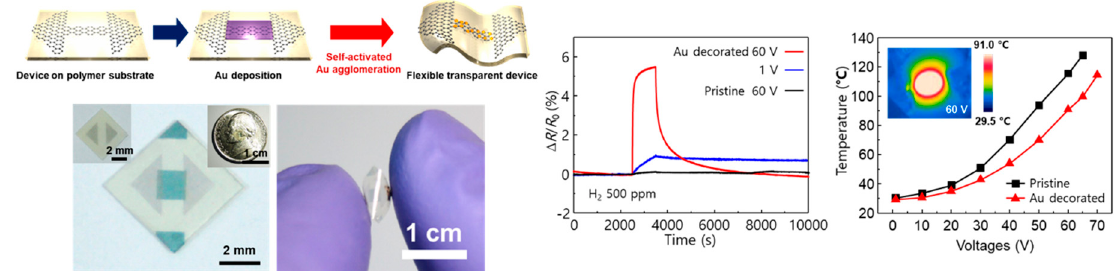
Figure 1. Transparent and flexible Au-decorated graphene microchannel gas sensor (Ref: Kim et al., Nanoscale , 2019 , 11 ,